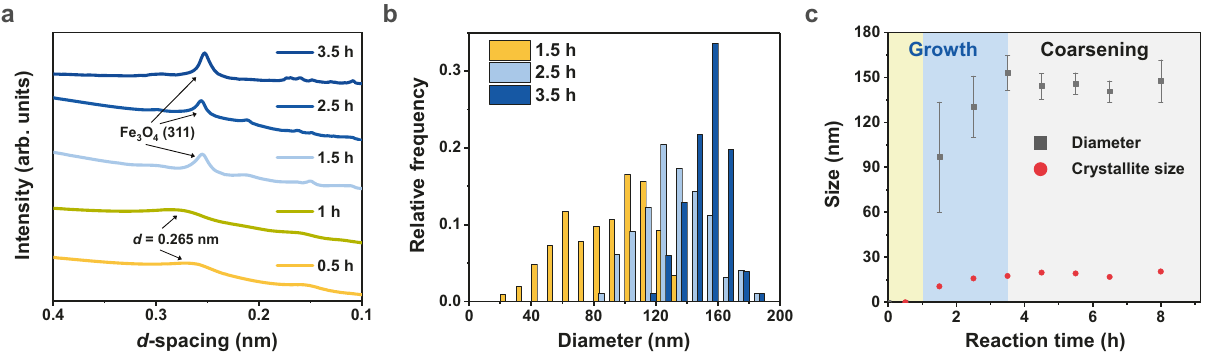
Fig. 2 Growth of Fe 3 O 4 mesocrystal. a Radial distribution pro fi les from the SAED patterns at all reaction stages. The position of main diffraction peaks originated from the intermediate phase is marked as d = 0.265 nm. b Size distributions obtained by measuring 200 Fe 3 O 4 mesocrystals. c Kinetic approximation of Fe 3 O 4 growth, indicating that the mesocrystal and crystallite sizes are similar after 3.5 h. Each data point was obtained from the mean of the Gaussian distribution ( n = 200) and Debye – Scherrer equation. The error bars represent